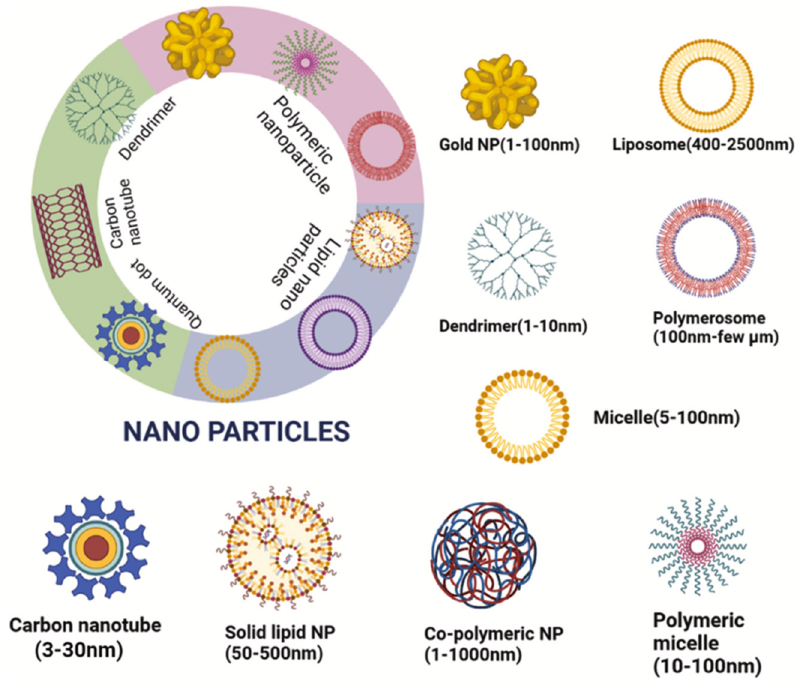
Figure 1. Various classes of nanocarriers [52].